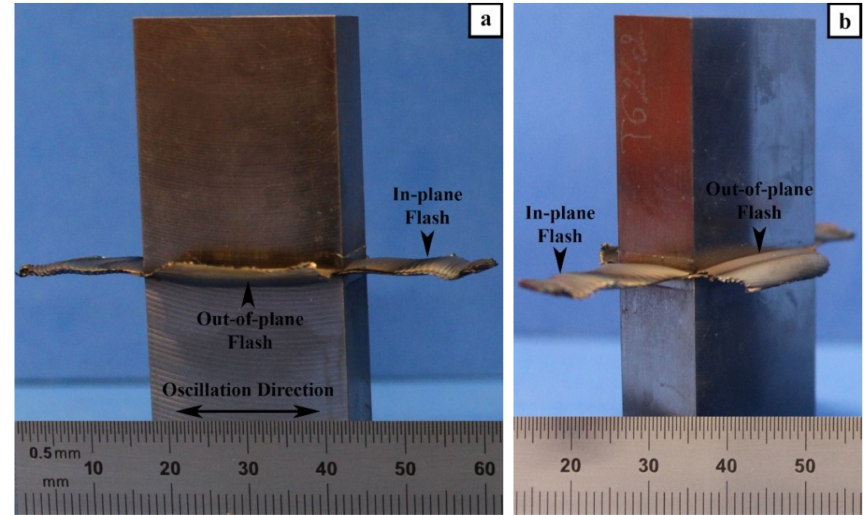
Figure 3. Linear friction-welded specimen with flash extruded along the edges: ( a ) front view ( b ) isometric view.